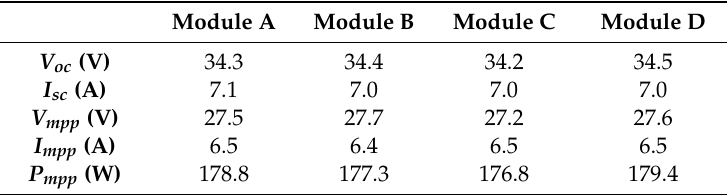
Table 3. Parameters of each module at nominal operating cell temperature (NOCT).